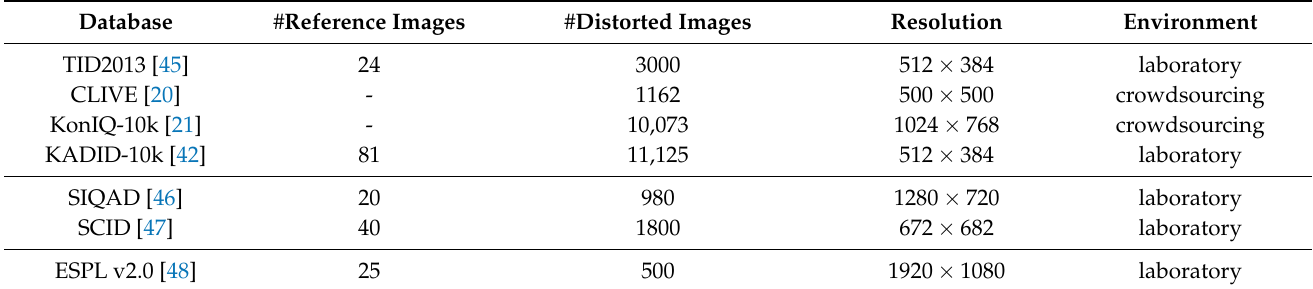
Table 3. Publicly available IQA benchmark databases used in this